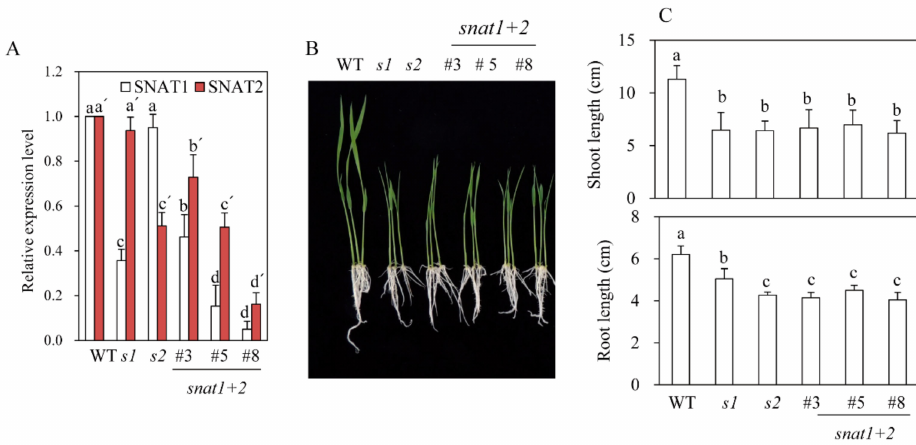
Figure 2. Expressions of SNAT isogenes and growths of snat1 + 2 rice seedlings. ( A ) qRT-PCR analysis of SNAT1 and SNAT2 messenger RNA (mRNA) in snat1 + 2 rice. ( B ) Seedling phenotypes of snat1 + 2 rice grown for one week. ( C ) Shoot and root lengths of snat1 + 2 ( n = 20). s1 = snat1 rice, s2 = snat2 rice, and snat1 + 2 = double-suppression rice. Di ff erent letters indicate significant di ff erences from the wild-types (Tukey’s post-hoc honest significant di ff erence (HSD) test; p <